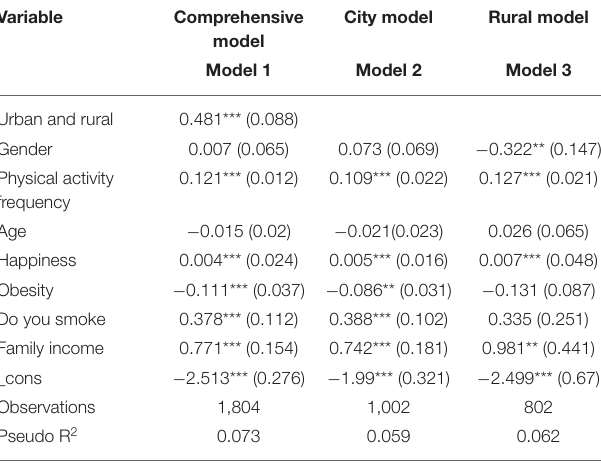
TABLE 2 | Regression model of physical activity and self-rated health identity of Chinese adolescents.